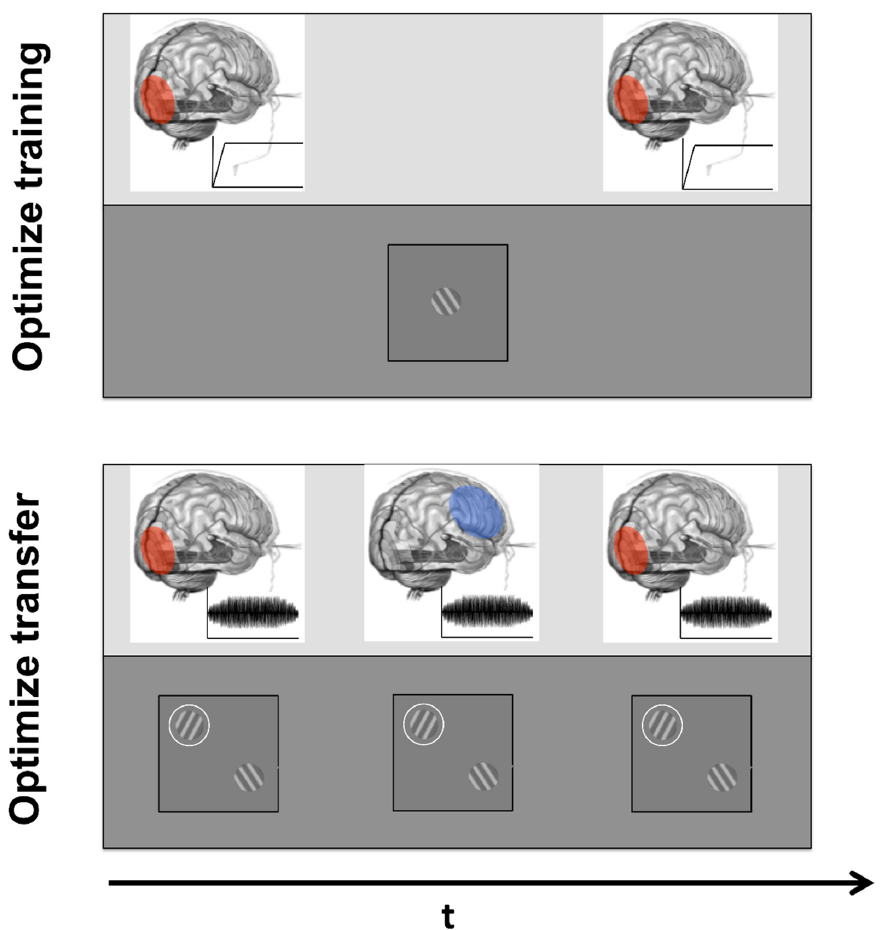
Figure 2. Examples of combined use of brain stimulation and perceptual learning to optimize learning (above) and transfer (below). Above: VPL can benefit from the help of tES to boost both neural plasticity before training (e.g., [72]) and consolidation after training [73]. Below: Having a task that engages both perceptual and attentional mechanisms and a stimulation protocol that targets both low- and high-level cortical regions might lead to larger generalization effects at both perceptual and cognitive levels.